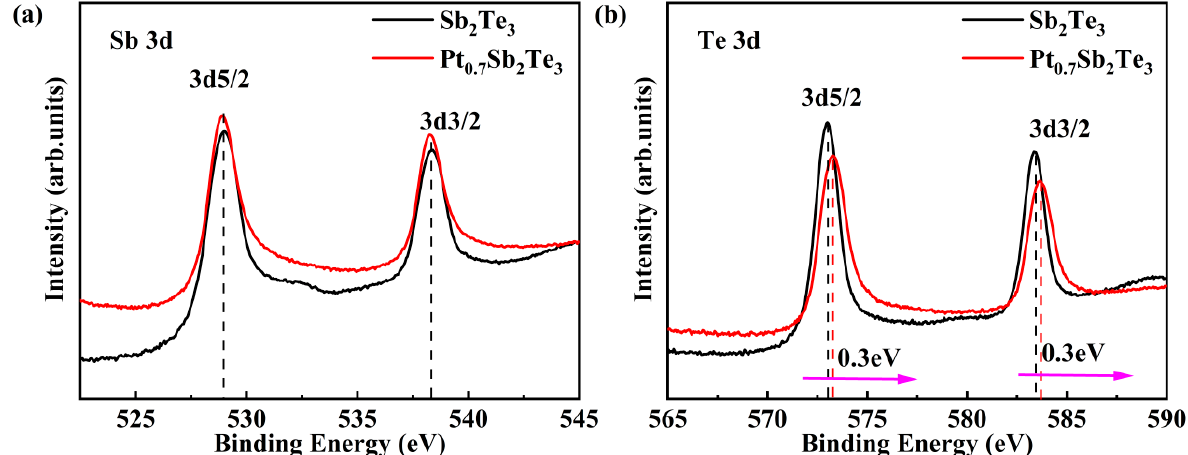
Figure 5. XPS spectra of Sb 2 Te 3 and PST films annealed at 260 °C ( a ) Sb 3d and ( b ) Te 3d.